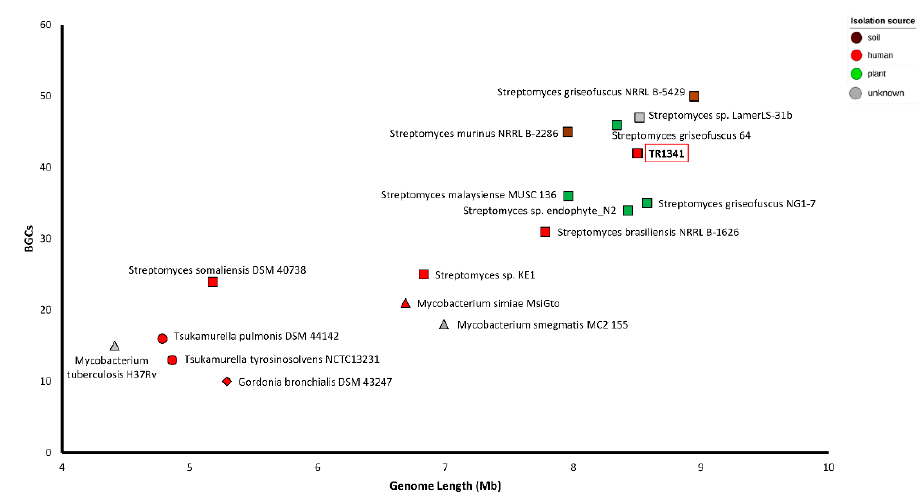
Figure 5. Relationship between genome size (Mb) and number of biosynthetic gene clusters (BGCs). Squares: Streptomyces species; triangles: Mycobacterium species; circles: Tsukamurella species; diamond: Gordonia bronchialis DSM